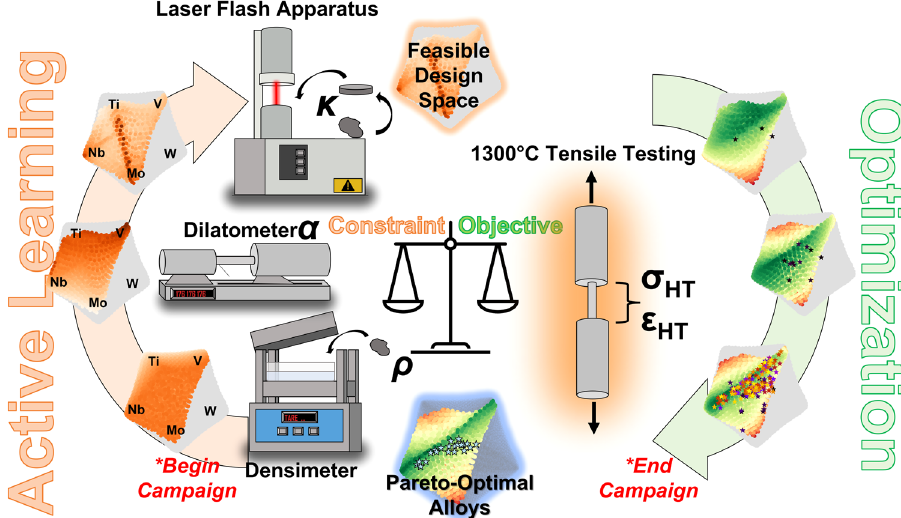
Fig. 7 Schematic representation of an experimental campaign utilizing the proposed framework. The process begins with a closed-loop exploration of the design space to identify the range of compositions that meet all requirements. This forms the feasible region of the design space. Optimization is then carried out within this region to identify a set of Pareto-optimal alloys as the fi nal outcome of the